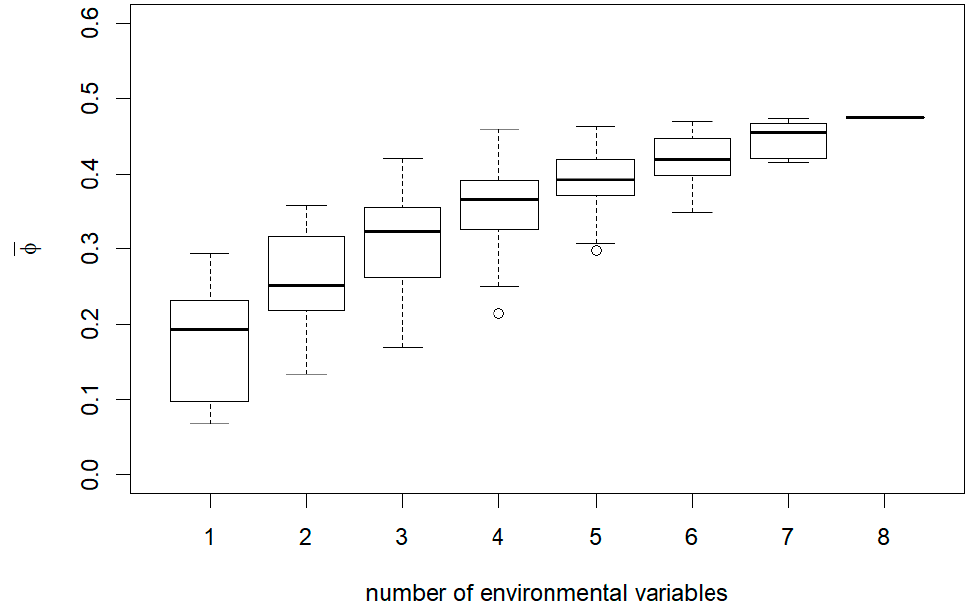
Figure A5. Box plot of mean phi coefficients ( φ ) of the FDMs generated by LDA as affected by the number of explanatory variables. Box plot shows median plus upper and lower quartiles for φ of FDMs with a given number of explanatory variables. Minimum and maximum values are indicated by the upper and lower whiskers (1.5 × interquartile range). Circles are outliers.